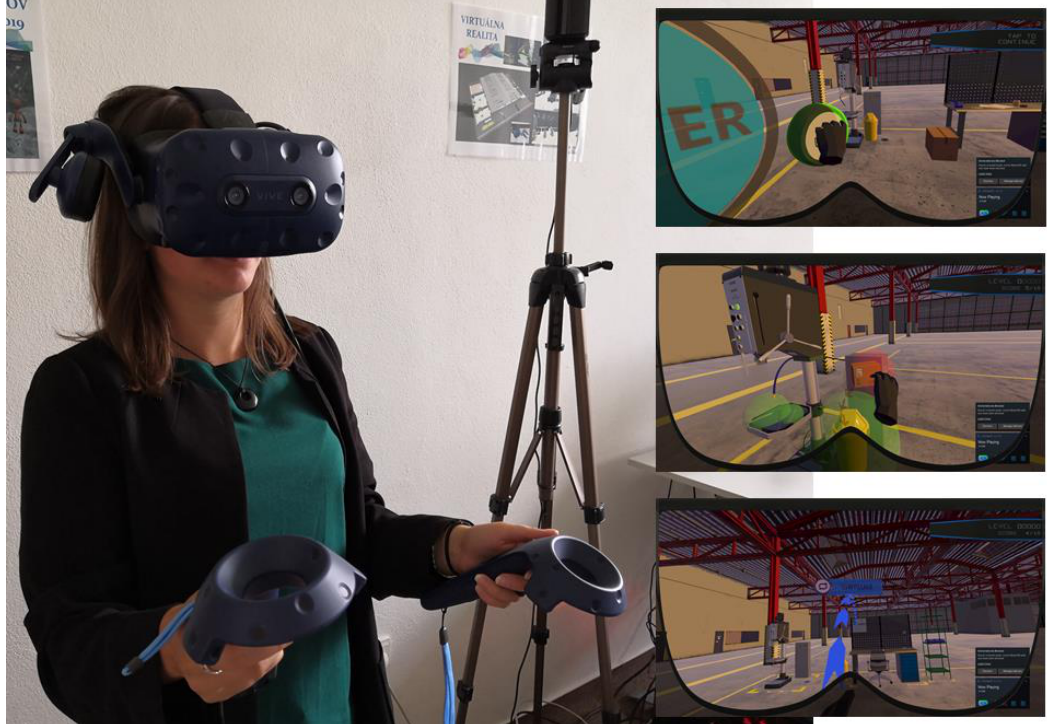
Figure 9. The 5S method educational game played by student.